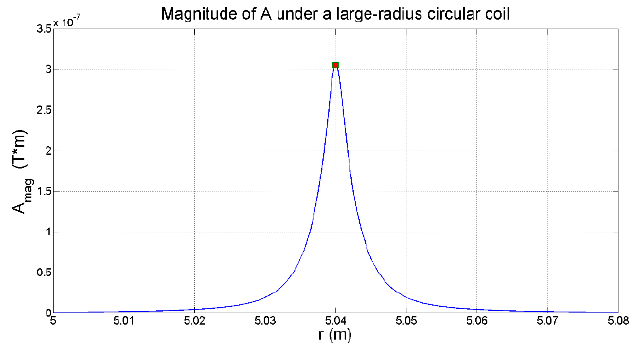
Figure 2. The magnitude distribution of A under a large-radius circular coil. Reproduced with permission from [15], IEEE, 2016.